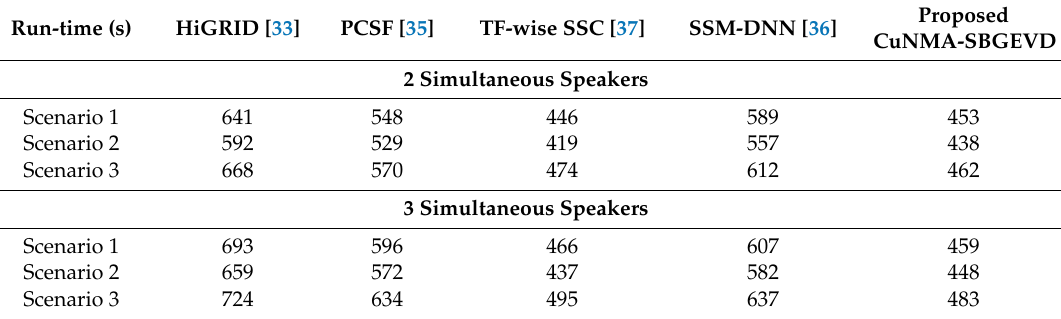
Figure 14. The averaged MAEE curves for the proposed CuNMA-SBGEVD in comparison with HiGRID, PCSF, TF-wise SSC, and SSM-DNN on real and simulated data for 3 simultaneous speakers, ( a ) for SNR = 5 dB and 0 < RT 60 < 700 ms, and ( b ) for RT 60 = 650 ms and − 10 < SNR < 20 dB. Table 4. Comparison of computational complexity between the proposed CuNMA-SBGEVD, HiGRID, PCSF, TF-wise SSC, and SSM-DNN algorithms on real data for 2 and 3 simultaneous speakers (run-time in second).